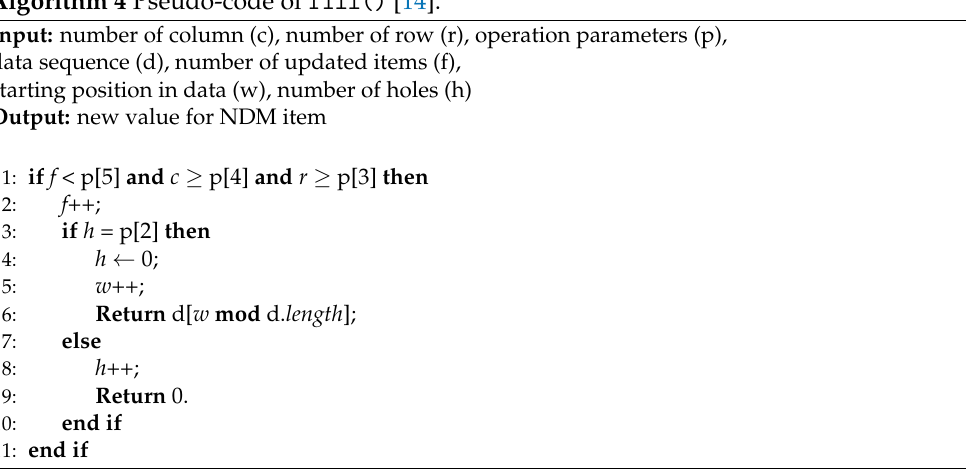
Algorithm 4 Pseudo-code of fill()